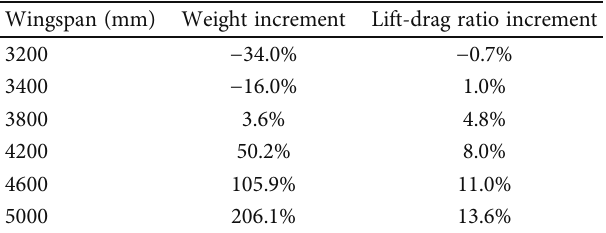
Table 4: Comparison of mass and aerodynamic performance between the SBW and the